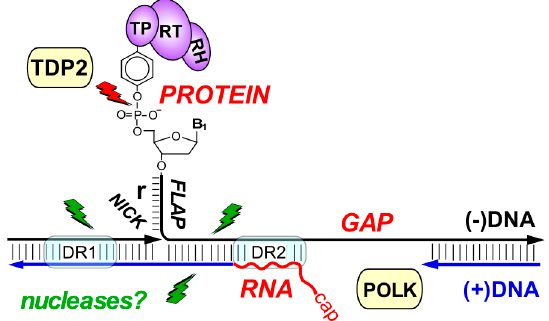
Figure 9. Summary of hepadnaviral RC-DNA as a multi-target DNA repair substrate. Close-up of the molecular peculiarities in RC-DNA. The unusual features of RC-DNA concentrate on a small region encompassing direct repeats DR1 and DR2. P protein is linked to the 5 ′ end of minus-strand DNA through a tyrosyl-DNA phosphodiester bond; the small “r” redundancy forms a flap preceded by a nick. The incomplete plus-strand starts with RNA and leaves a gap that makes the opposite minus-strand single-stranded. The host enzyme TDP2 can cleave the tyrosyl-DNA-phosphodiester bond to release P protein [49] yet as in repair of cellular protein-DNA adducts alternative, probably nucleolytic repair pathways are likely to exist (green lightning symbols). Translesion DNA polymerase κ (POLK) is thought to fill-in the gap in plus-strand DNA [46] but can probably also be substituted for by other repair polymerases. Factors required for the other RC-DNA modifications have not yet been identified.